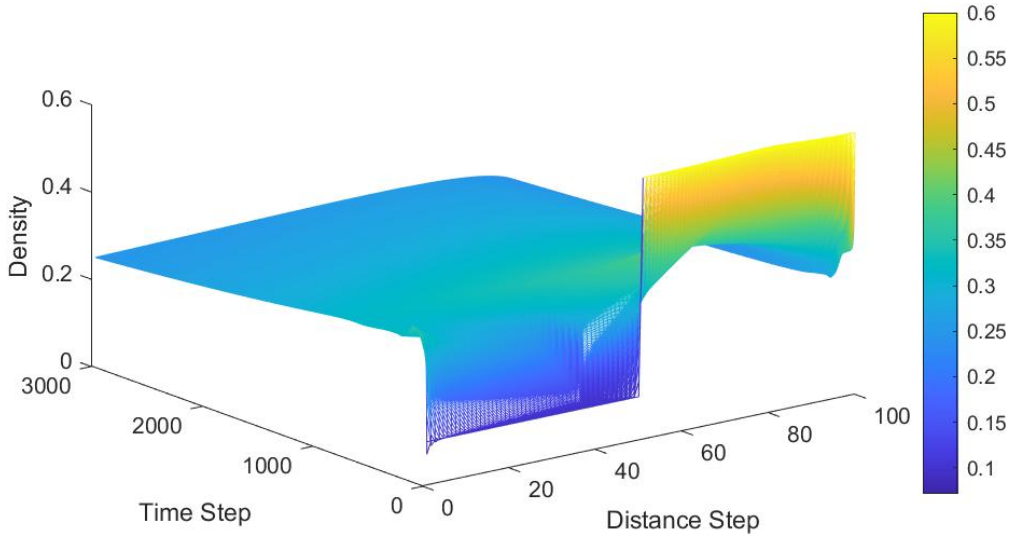
Figure 14. Density behavior of the PW model on a ring road.